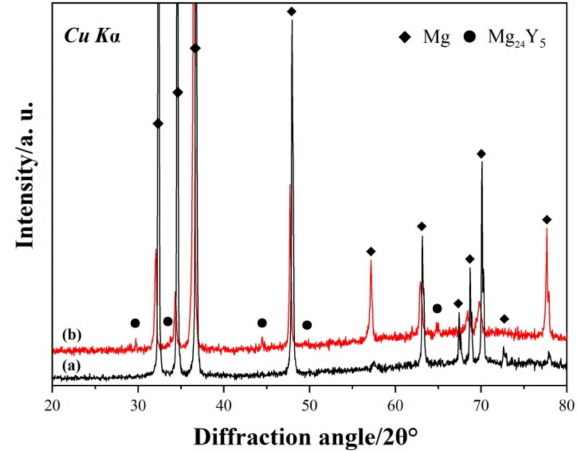
Figure 4. XRD patterns of the as-cast (a) pure Mg and (b) Mg-3Y